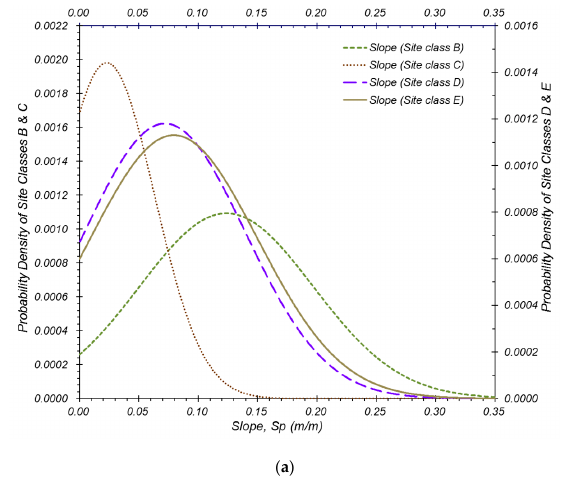
Table 3. Empirical slope range for site classification according to V S 30 of NEHRP (National Earthquake Hazards Reduction Program)